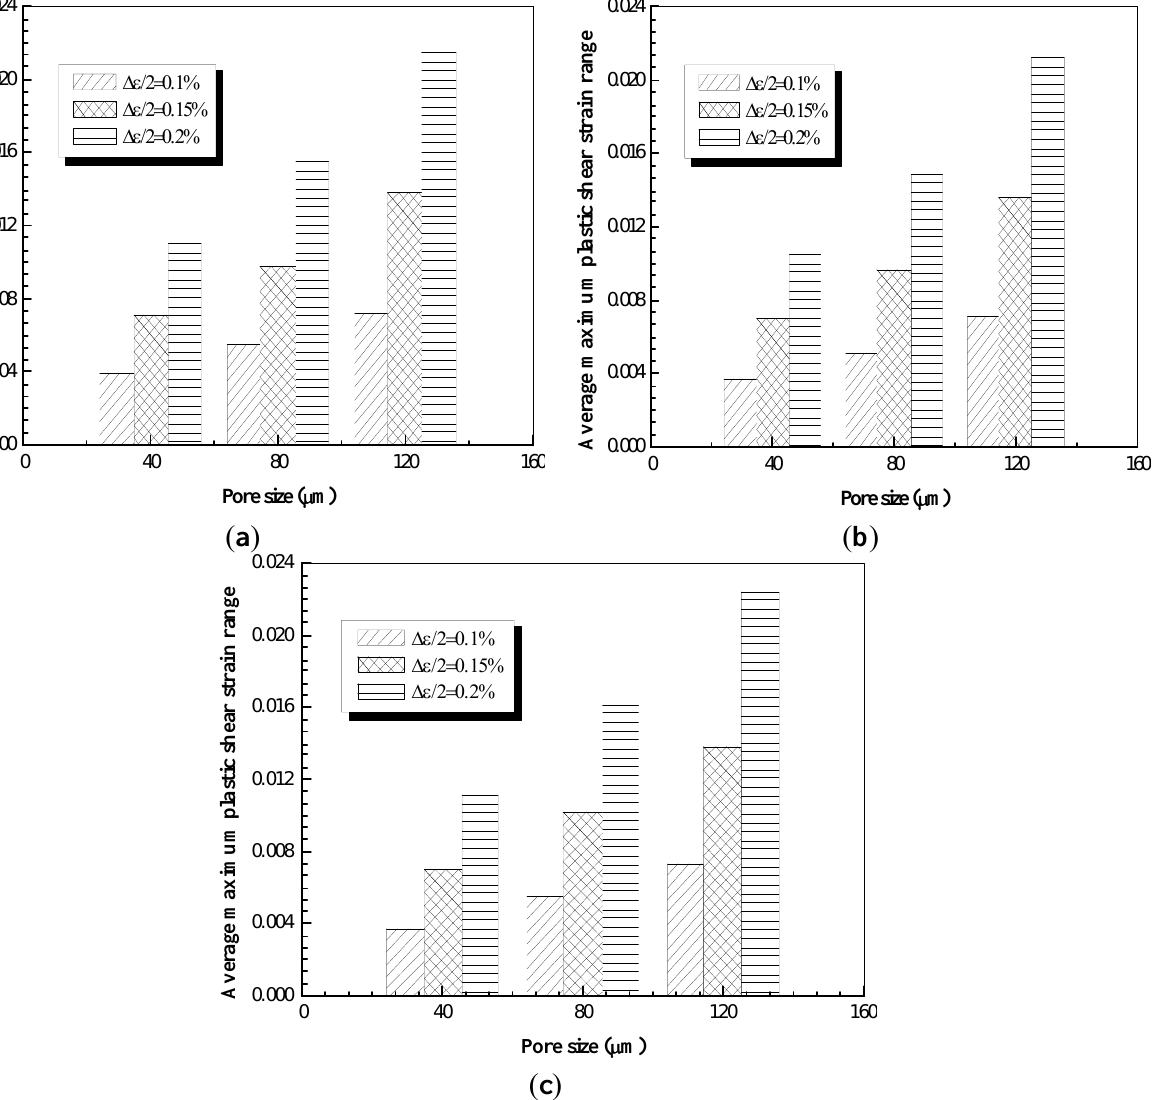
Figure 18. Pore size effect the average maximum shear under the loading ratio